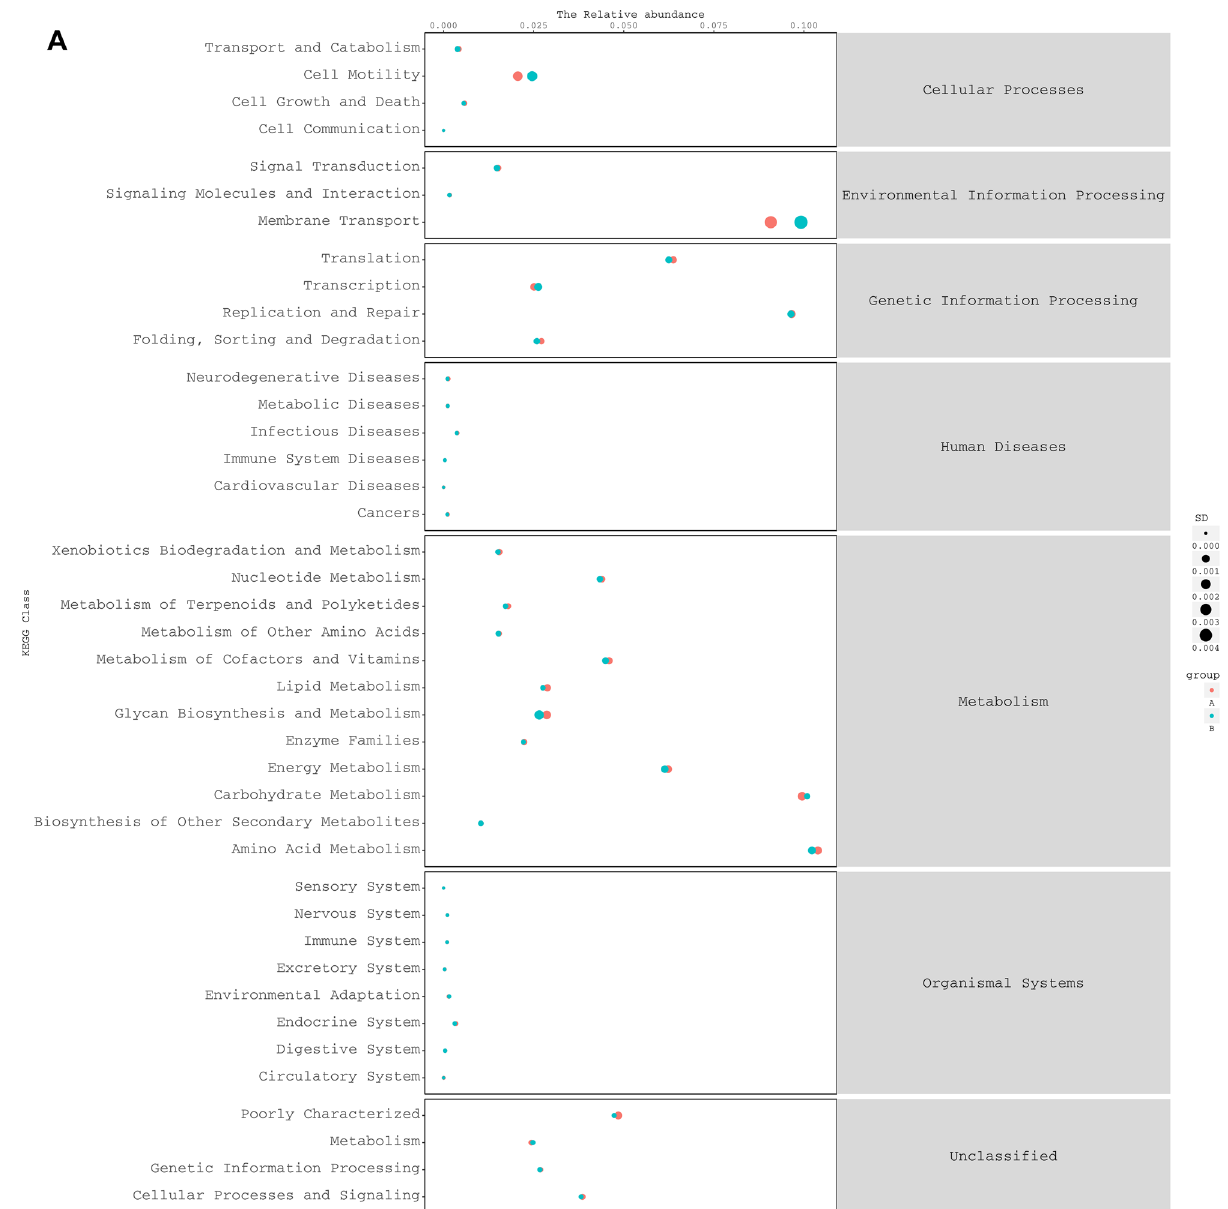
Figure 6. Comparison of predicted KEGG pathways for the fecal bacterial microbiota of Tibetan sheep (A) . Comparison of predicted KEGG pathways for the fecal bacterial microbiota of yak (B)